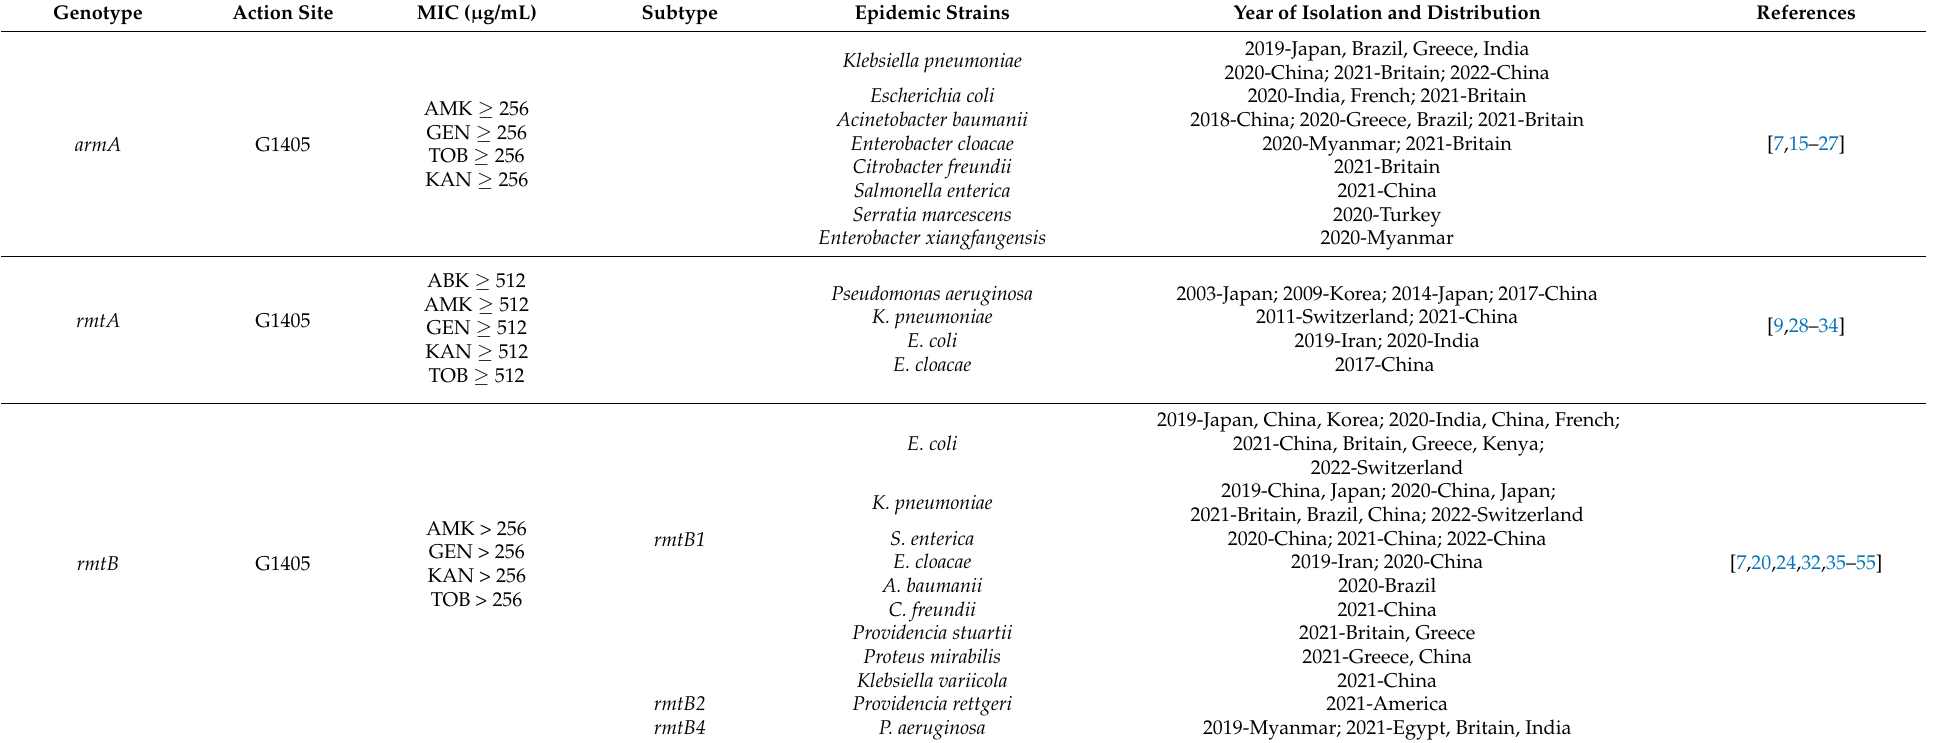
Table 1. The strains with 16S rRNA methylase resistance gene and their